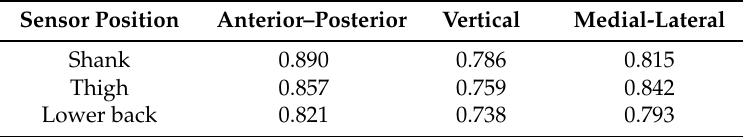
Figure 2. Receiver operating characteristic (ROC) curves for all sensors and all the three axes. Table 1. Area under the ROC curve across all the subjects for the different sensor positions and axes.